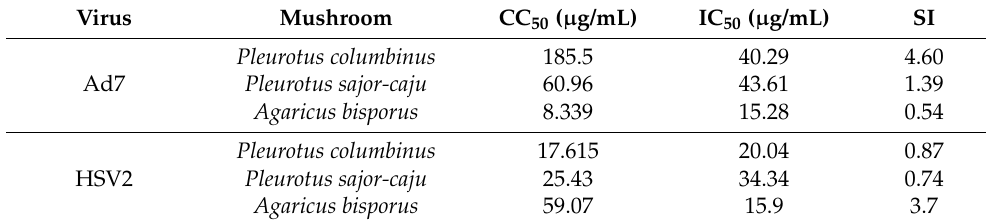
Table 5. Antiviral activities of the mushroom extracts.